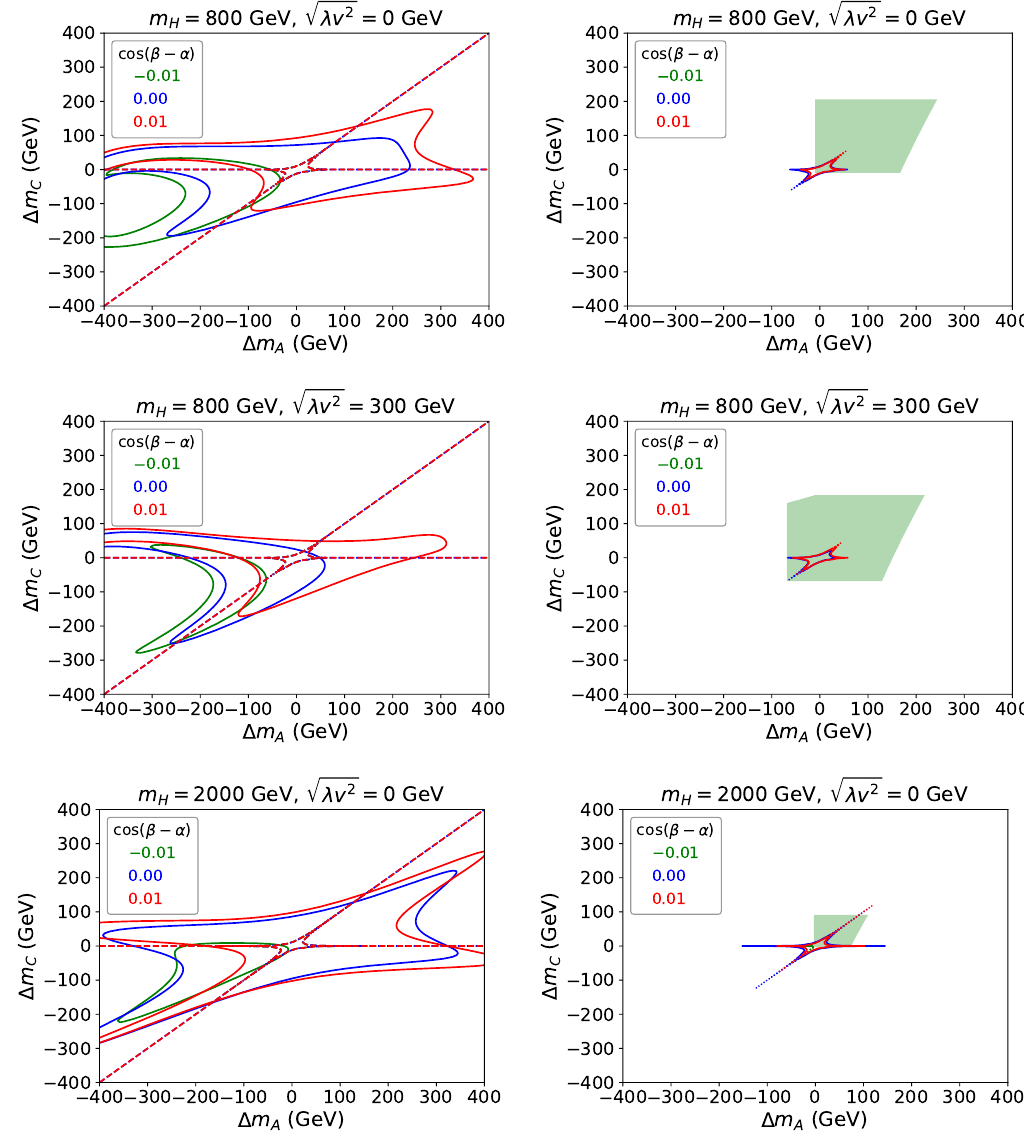
Figure 11 . Allowed region from three-parameter (cid:12)tting results at 95% C.L. in the (cid:1) m A (cid:11) ), for Higgs (solid curve) and Z -pole (dashed curve) constraints plane and also varying cos( (cid:12) (cid:0) (left panel), and combined constraints (right panels), with upper row for m H = 600 GeV, p (cid:21)v 2 = 0, middle row for m H = 600 GeV, p (cid:21)v 2 = 300 GeV, and bottom row for m H = 2000 GeV, p (cid:21)v 2 = 0. tan (cid:12) = 1 is assumed for all plots. Shaded region is used to indicate the theoretical constraints at (cid:11) ) = 0. cos( (cid:12) (cid:0)